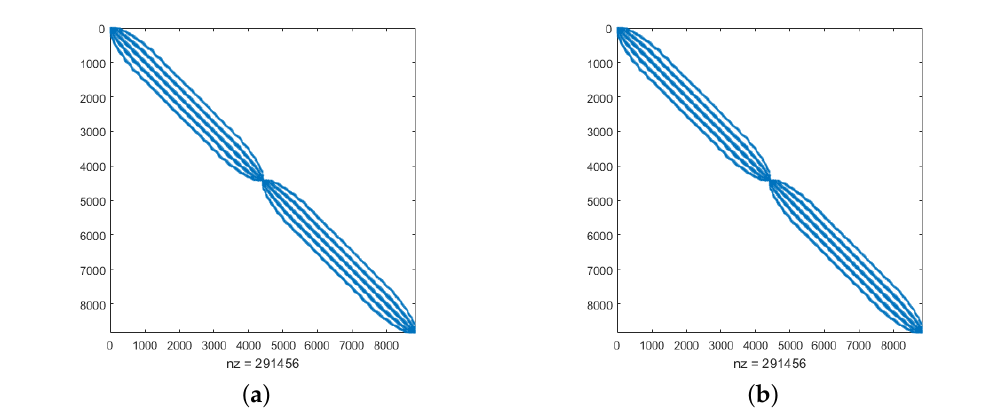
Figure 3. Sparsity pattern for Example 1 with ( a ) TPS and ( b ) MQ by taking dx = 1 n c =